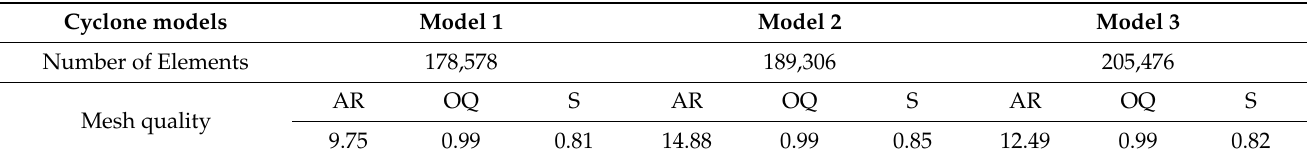
Figure 3. Meshing of the cyclone models; ( a ) Model 1 (basic), ( b ) Model 2 (added socket 1), and ( c ) Model 3 (added socket 2). Table 2. Mesh quality of cyclone